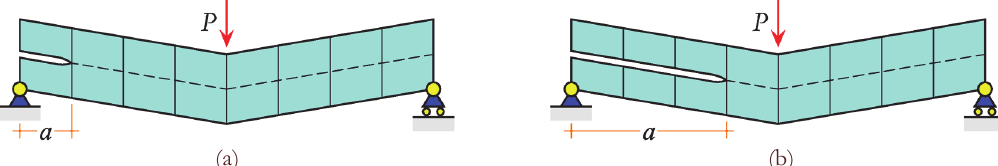
Figure 3: Rigid-connection model of the ENF test: deformed shapes due to shear for (a) shorter and (b) longer delamination